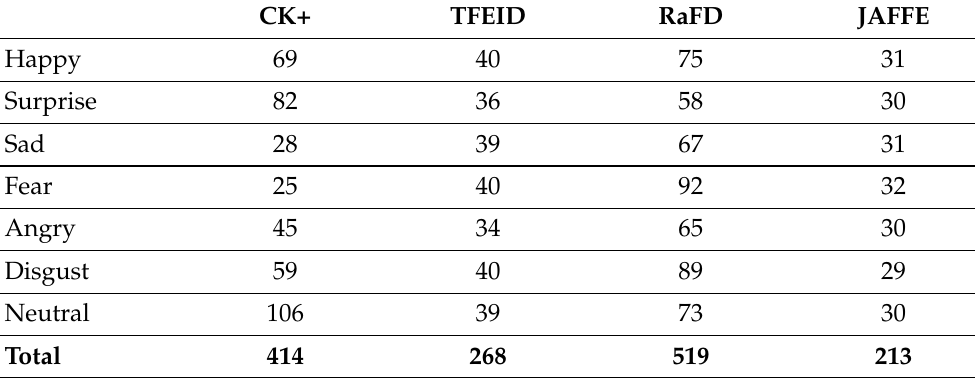
Table 2. Numbers of images in the databases used in our studies for seven facial expression